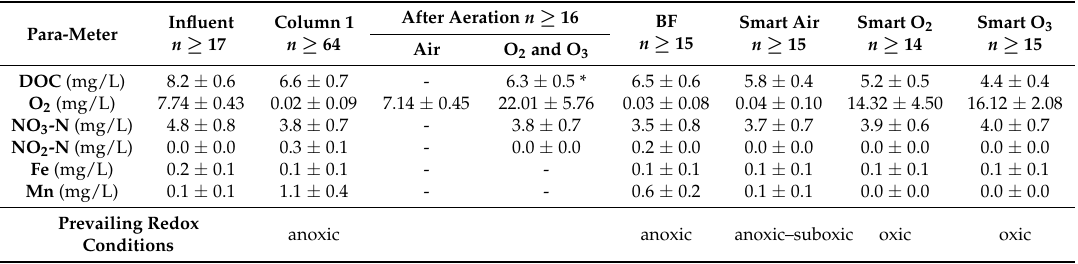
Table 1. Dissolved organic carbon (DOC) concentration and redox parameters measured in the system influents and effluents as well as after the aeration with air, pure oxygen or ozone respectively. After Aeration n ≥ Influent Column 1 Para-Meter n ≥ 17 n ≥ 64